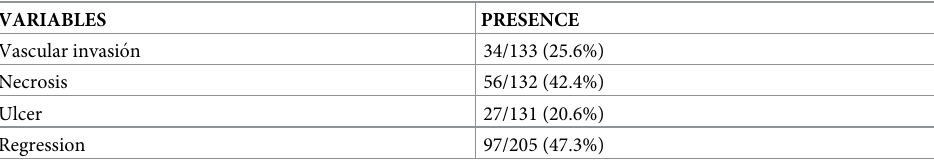
Table 3. Basic histological variables.